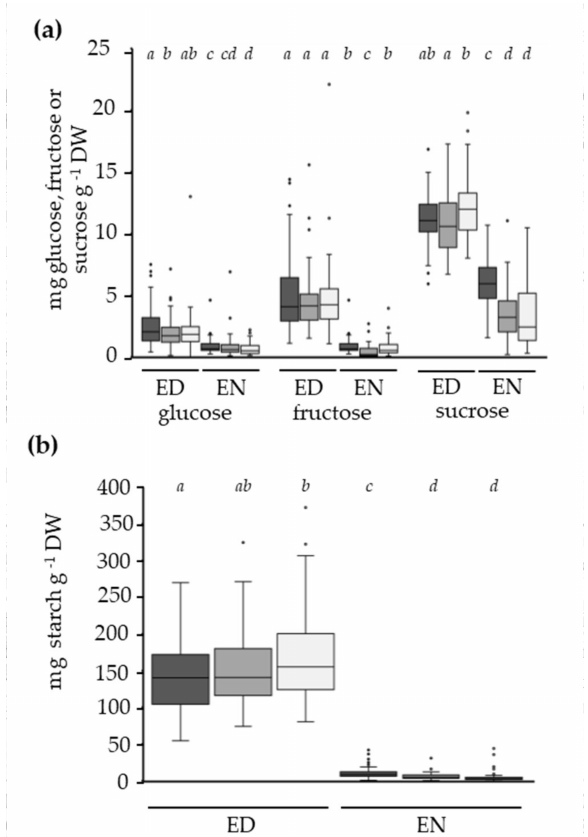
Figure 2. Glasshouse effects on variation in diel leaf glucose, fructose, and sucrose ( a ) contents and starch ( b ) content. One hundred and eighty-five individual genotypes were evenly distributed between three glasshouse chambers. The first chamber faced north and received more morning sun (dark grey), and the second chamber was positioned between the two chambers and received more afternoon sun (light-grey), and the third chamber faced south and received more evening sun (white). The letter pairs ( a–d ) indicate significant differences between glasshouse chambers ( p < 0.05) determined by analysis of variance and Tukey’s Honest Significant Difference (HSD) post-hoc comparison. Measurements for glucose, fructose, sucrose, and starch content were the same as described in Figure 1. 3.3. The Relationship between Glucose, Fructose, Sucrose, and Starch Contents in White Clover Leaves The relationship between NSC contents was determined using Spearman’s rank